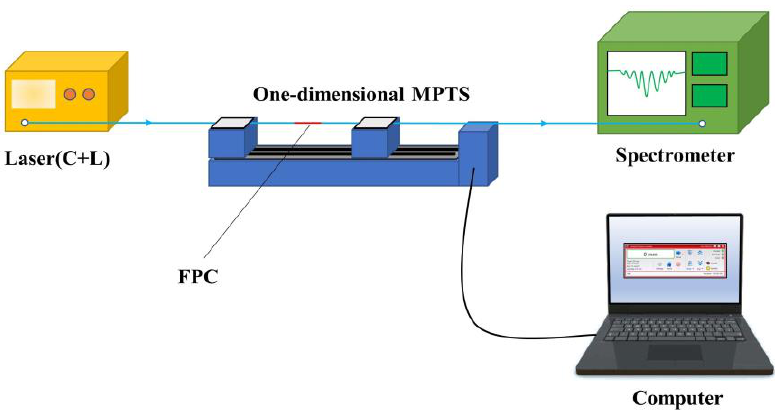
Figure 9. The schematic configuration of the strain response test system.